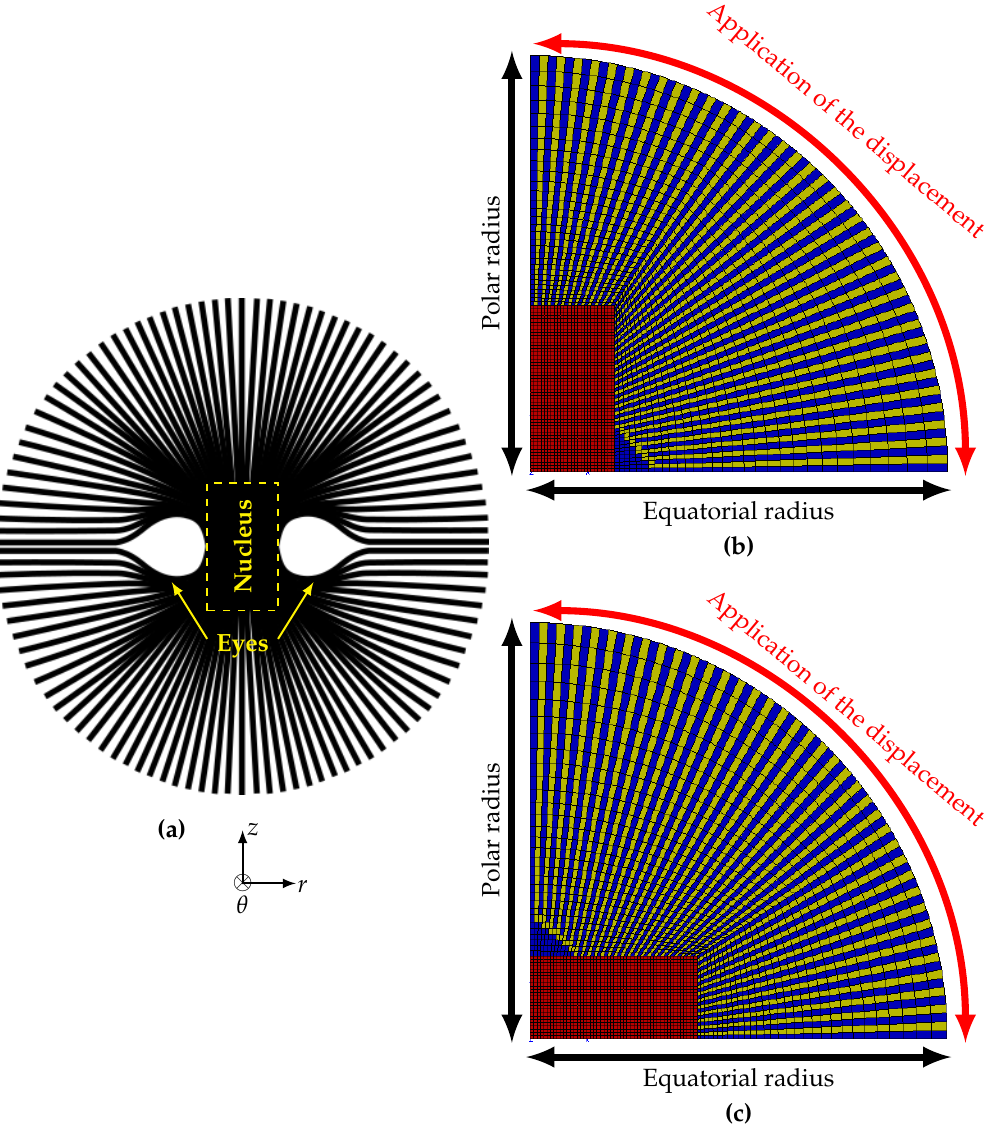
Figure 1. ( a ) Simplified sketch of a spherulite with the stiff nucleus inside and the presence of “eyes” [5]; ( b ) Finite Element (FE) meshes representing half of an “idealized” spherulite with cylindrical nucleus in the centre; ( c ) FE meshes used for transverse tensile stress loading applied on a spherulite. Note: for ( b ) and ( c ) Crystalline lamellae in yellow, amorphous lamellae together with the “eyes” in blue, nucleus in